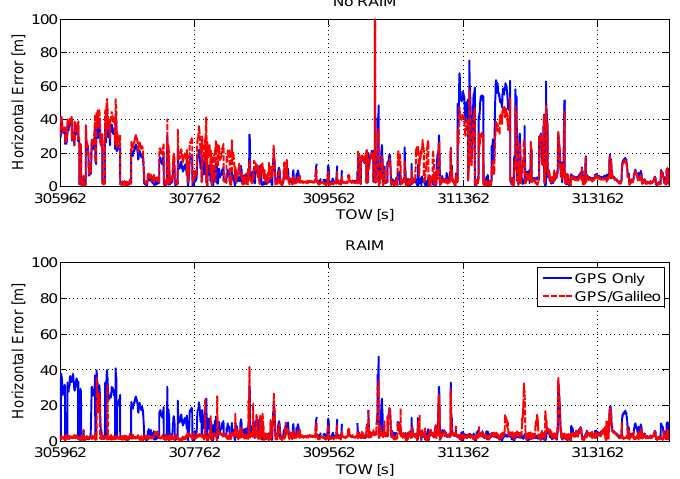
the red line is lower than the blue one.